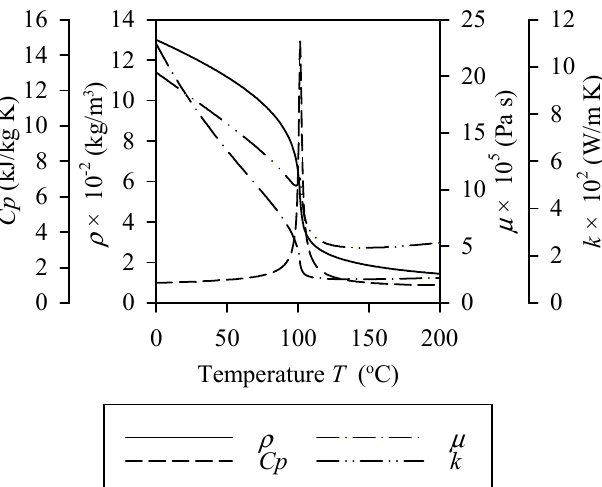
Figure 1. The enormous variations of physical properties for R-22 at a pressure of 5.5 MPa [5], where ρ is density, Cp is specific heat capacity, μ is viscosity, and k is thermal conductivity, respectively.